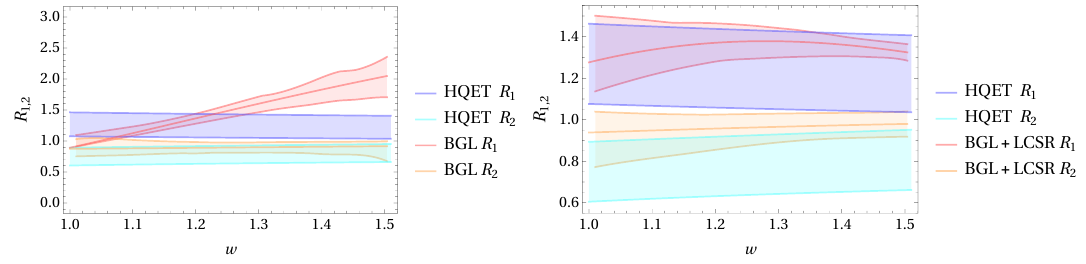
Figure 4 . Form factors ratios R 1 ; 2 from the (cid:12)ts with strong unitarity bounds without (left) and with LCSR (right) input compared with their NLO HQET predictions, with parametric uncertainty combined in quadrature with a 15% theoretical